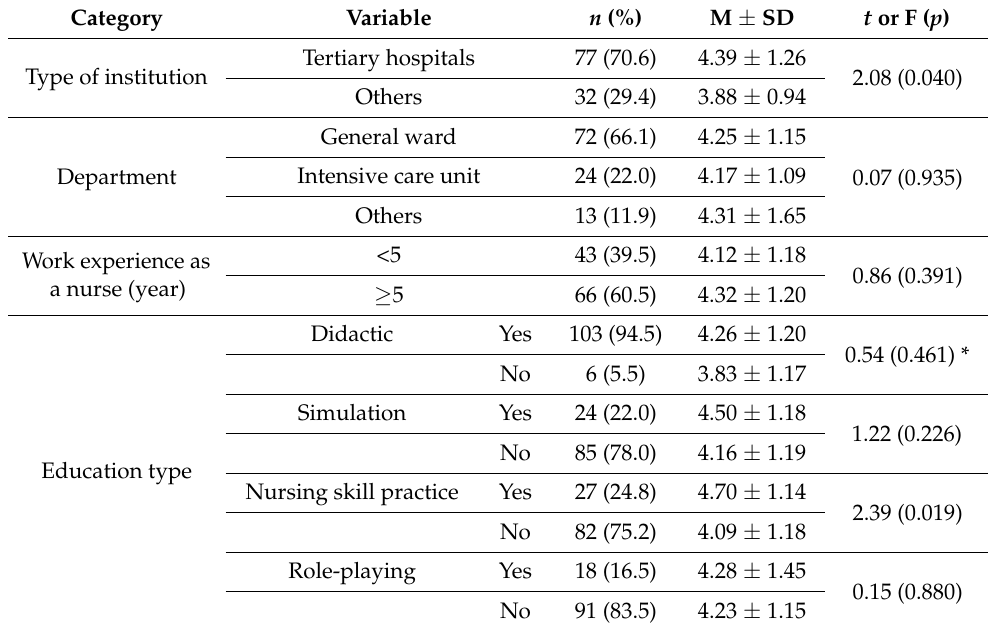
Table 2. Experiences of preceptorship training and satisfaction with training courses ( n =